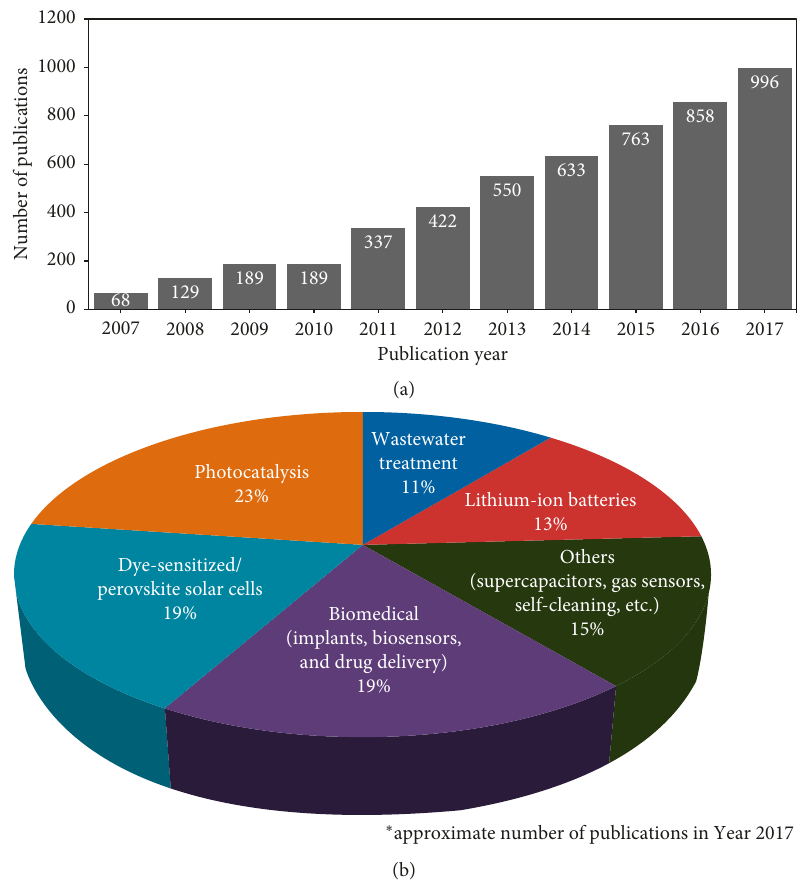
Figure 1: (a) The increasing trend outlining the number of papers published on TiO 2 nanotubes from 2007 to 2017 (data were obtained from the Science Direct database on Oct 1, 2018, using keywords of “TiO 2 nanotube” with result filters of review articles and research articles under the article type); (b) range of applications of TiO 2 nanotubes and their respective percentage with regard to the number of published papers within the area of TiO 2 nanotubes in the year 2017 (data were obtained from the Science Direct database on Oct 1, 2018, using keywords “TiO2” and “nanotube” and “ corresponding keywords shown in the pie chart ,” with result filters of review articles and research articles under the article type and year